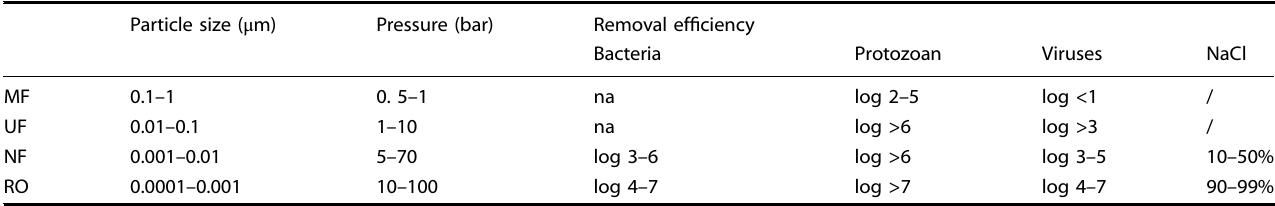
Table 8. Comparison of MF, UF, NF, and RO membranes 84,191 .